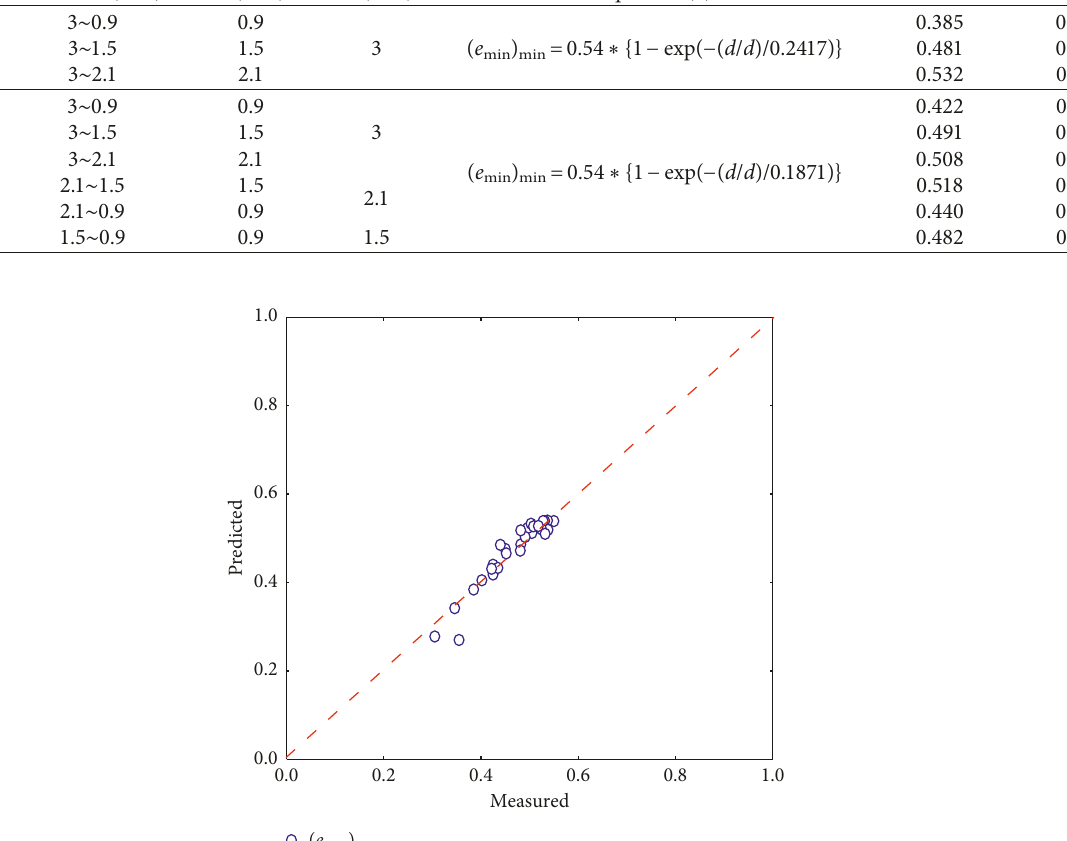
Figure 12: Comparison between the predicted and measured ( e Table 6: Descriptions of the alternative materials. Particle